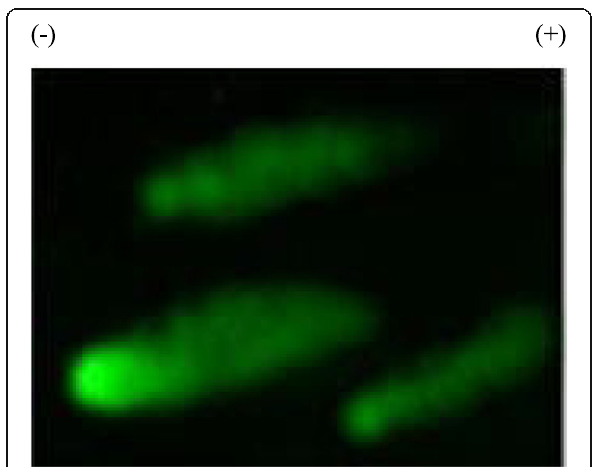
Fig. 5 Type IV DNA damage